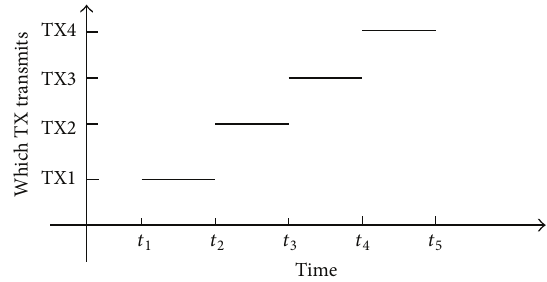
Figure 2: Example of a TDM scheme: 4 transmitters transmitting at times. Here 𝑡 = [𝑡 1 , 𝑡 2 , 𝑡 3 ,𝑡 4 ] 𝑇 ; 𝑑 Pulse = [𝑑 TX 1 , 𝑑 TX 2 ,𝑑 TX 3 , 𝑑 TX 4 ] 𝑇